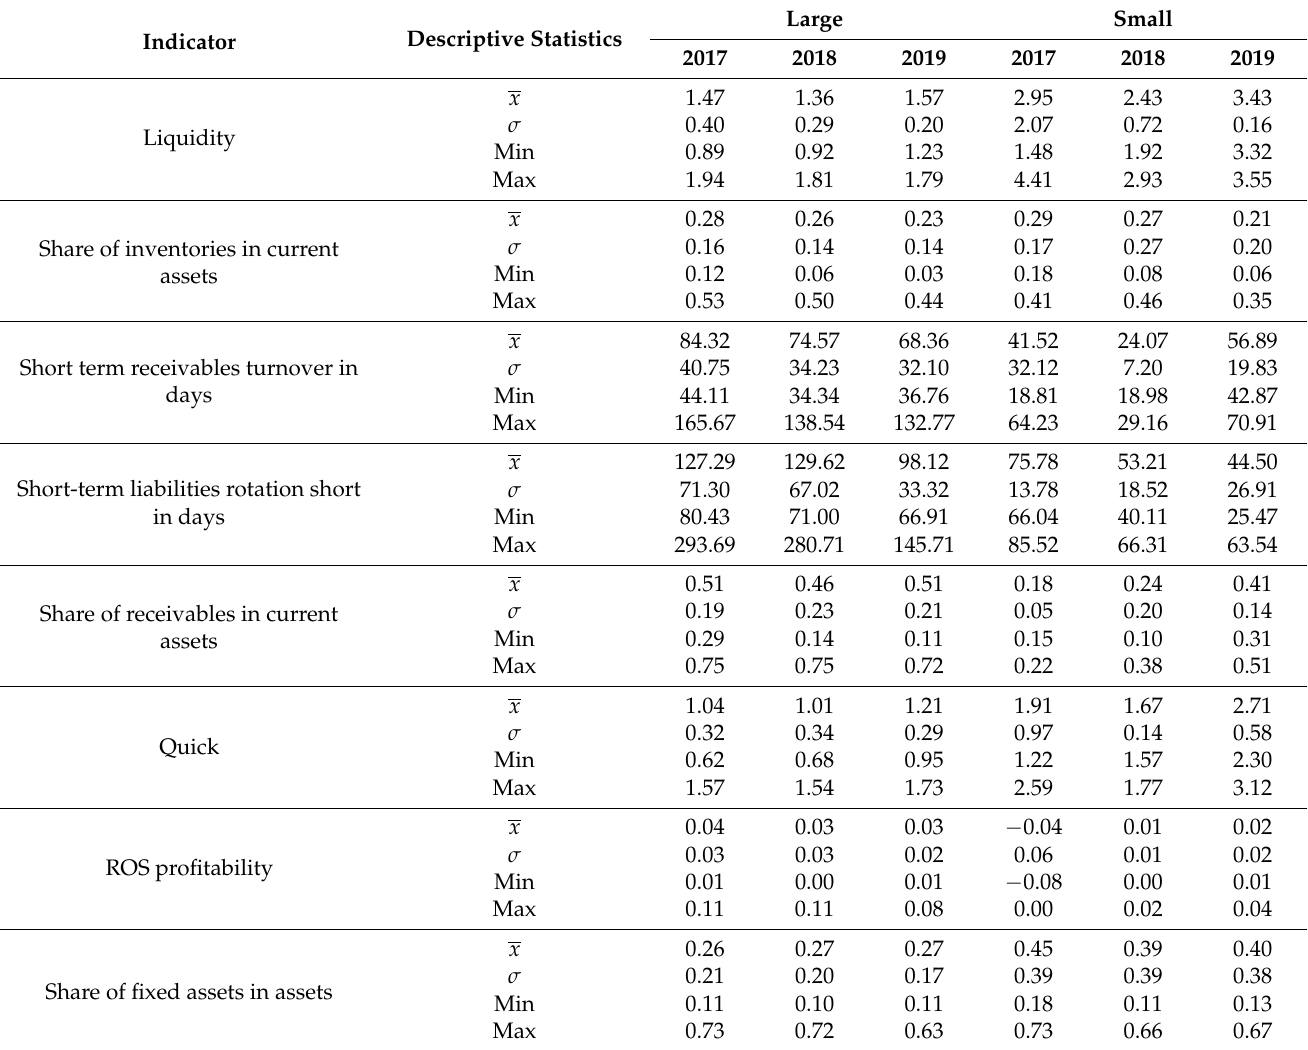
Table 1. Descriptive statistics of the basic financial